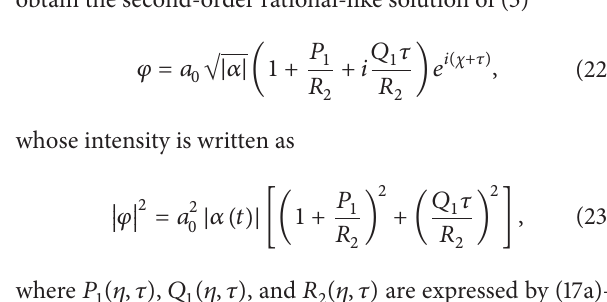
respectively. It can be observed from Figures 2(a)-2(b) that the pattern of the rogue waves is the same when the gravity field 𝑏 takes any value. However, it is found from Figures